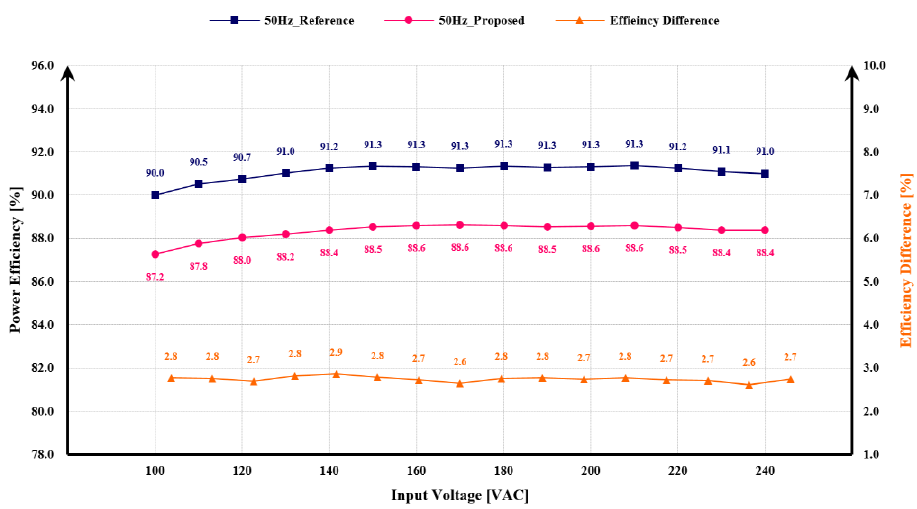
Figure 8. Power efficiency and efficiency difference according to the input voltage.